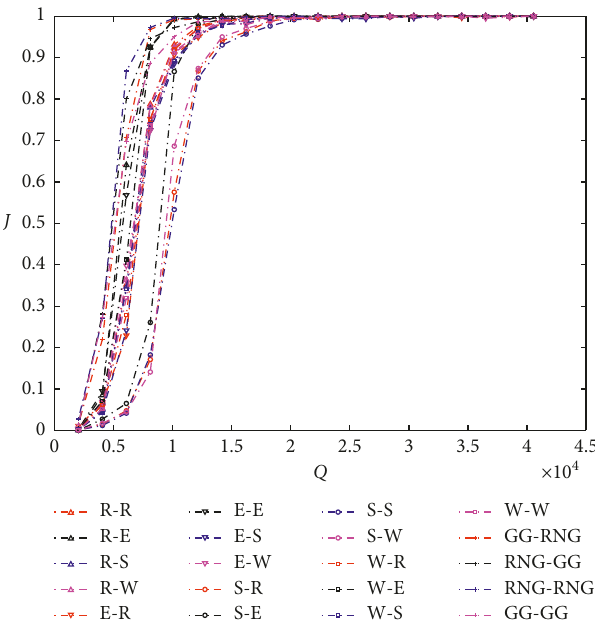
Figure 9: Randomly coupled multilayer network performance as the total traffic flow